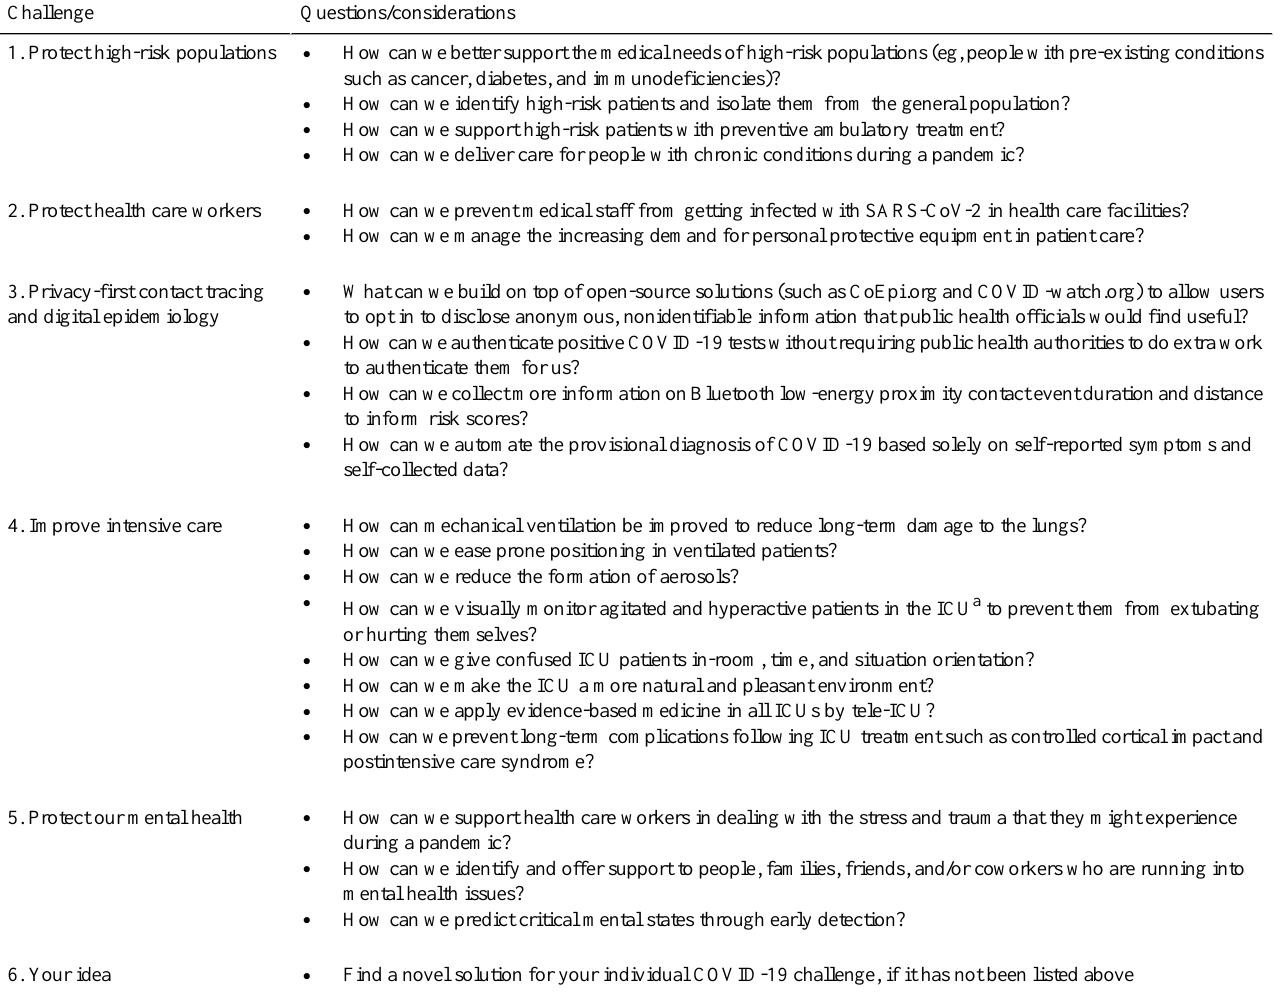
Table 1. Overview of the hackathon’s challenges. A total of six COVID-19–related challenges were identified in close cooperation with frontline physicians and